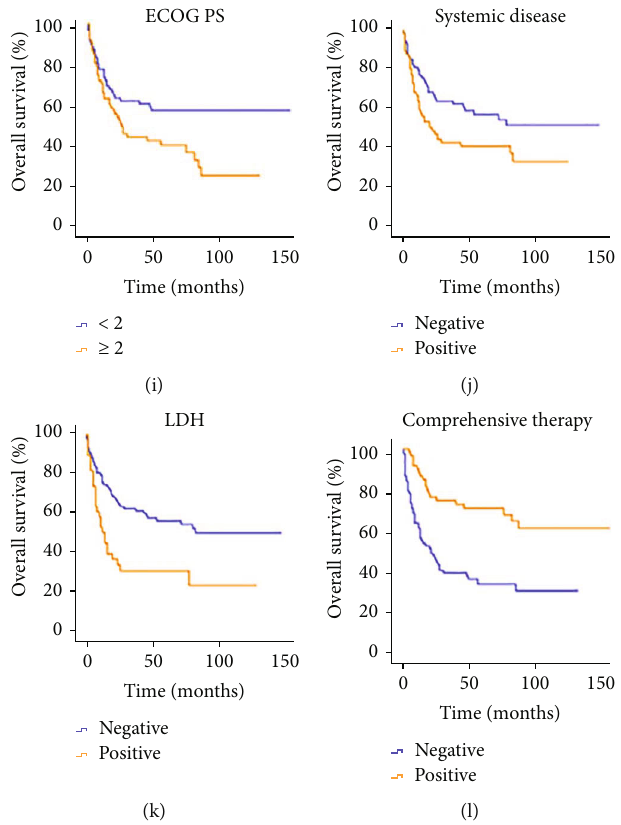
Figure 3: Univariate analysis of patients with DLBCL among various groups. (a – l) Univariate analysis for patients with di ff use large B cell lymphoma among various groups. (a, d – k) The OS of patients with aaIPI > 2 , positive BCL-2, positive YWHAZ, primary and nodal site, age ≥ 60 , hyphemia, ECOGPS ≥ 2 , positive systemic disease, or positive LDH was worse than that of patients with negative ones, respectively. (b, c) The OS of patients with positive BAD or BAX was better than those patients with negative BAD or BAX. (l) The OS of patients receiving comprehensive therapy was longer than those without comprehensive